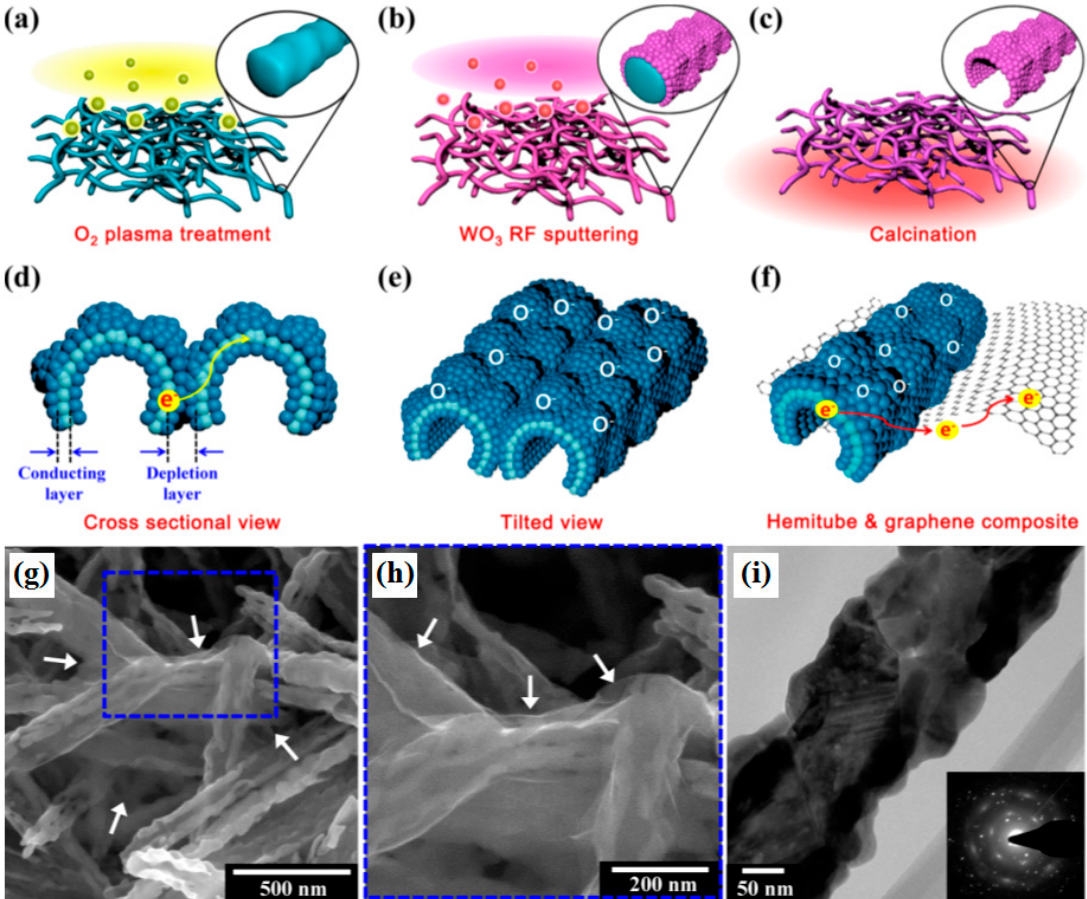
Figure 1. ( a – e ) Schematic illustration of formation of 3D graphene-WO 3 hemitube architectures; ( g – i ) SEM and TEM image with SAED pattern in the inset of graphene-WO 3 hemitube composite. Reproduced with permission from [57], © 2012 American Chemical Society